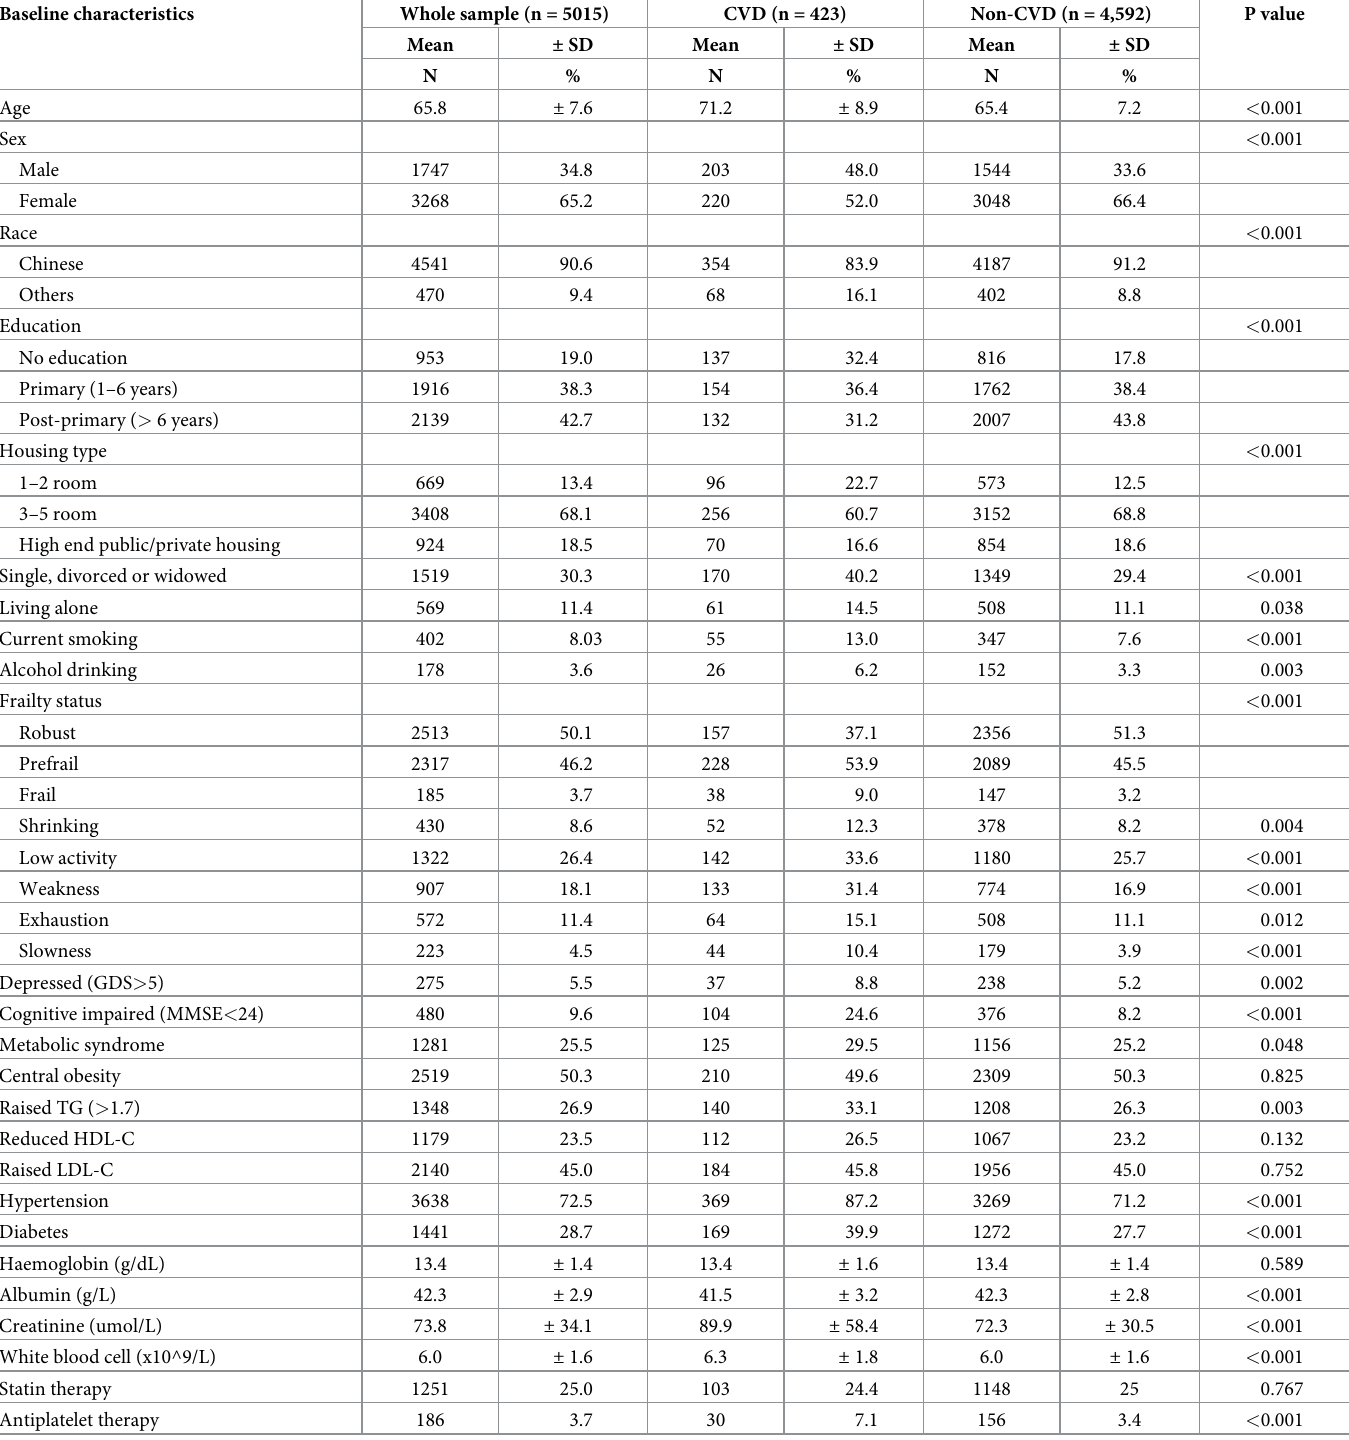
Table 1. Baseline characteristics in overall sample and by CVD and non-CVD